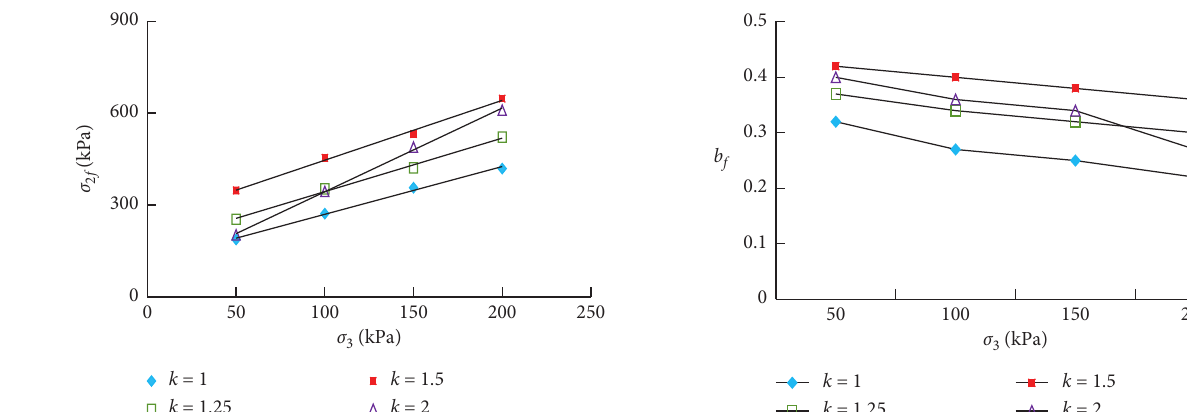
and σ in a failure state. 2 f 3 c